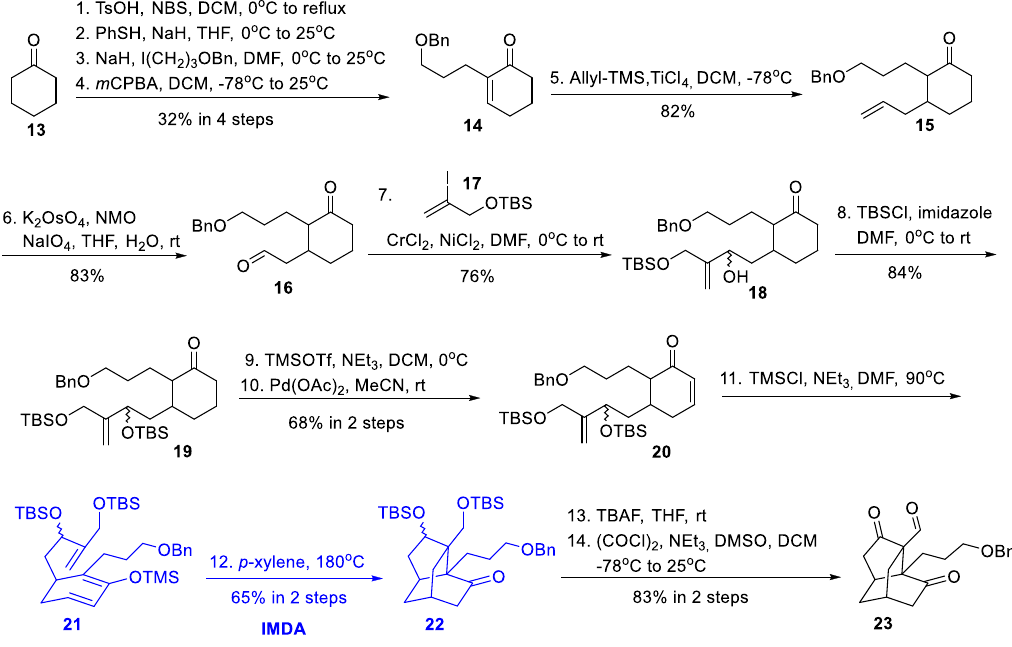
Scheme 2. Synthesis of the isotwistane cage (Fan,